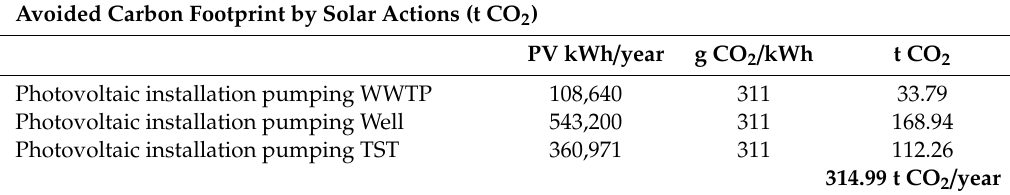
Table 9. Summary of avoided carbon footprint by solar actions (t CO 2 ).